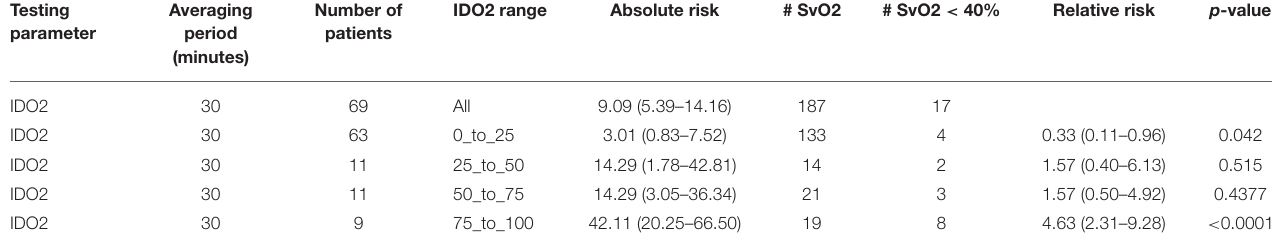
TABLE 2 | Absolute risk and relative risk of experiencing SvO2 < 40% for each IDO2 bin. Testing parameter